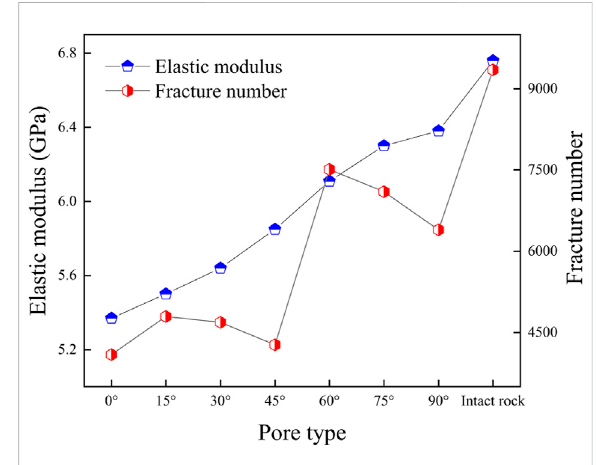
FIGURE 5 Relationship between elastic modulus and fracture number of single fracture-hole rock model with different fracture